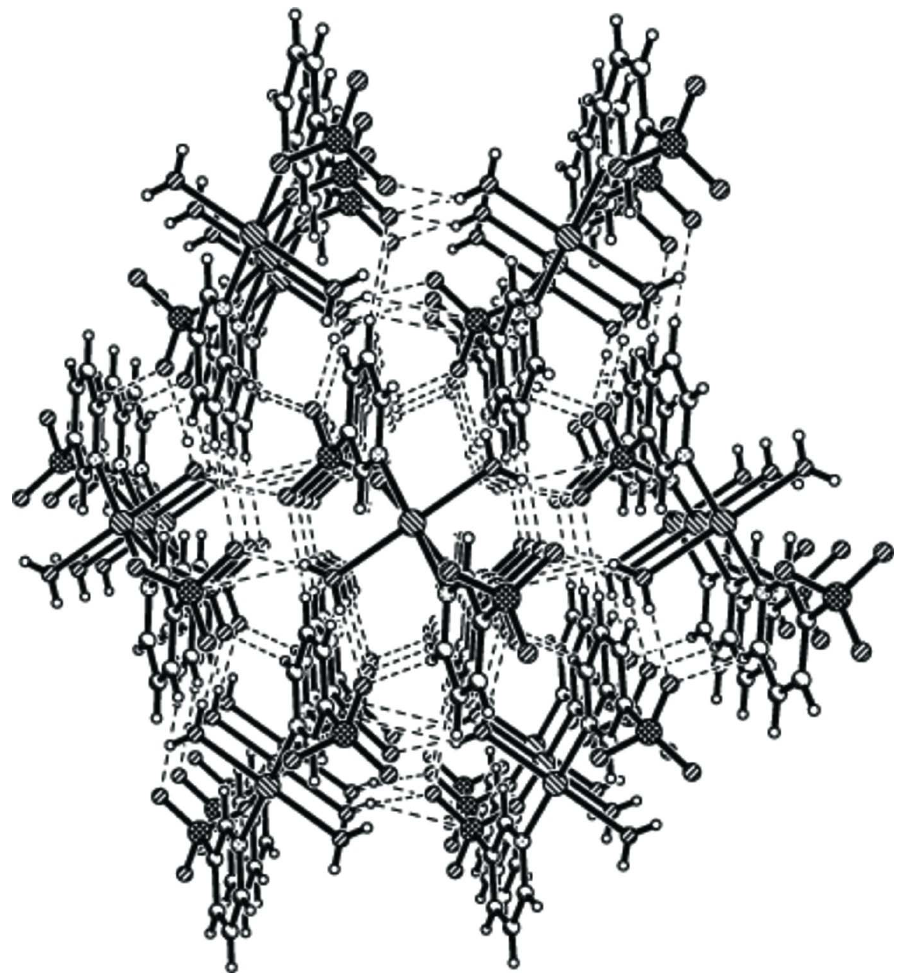
Crystal packing of (I) viewed approximately down the a-direction showing the hydrogen bonding interactions as dashed